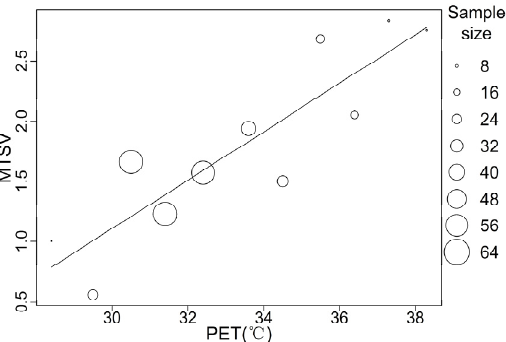
Figure 2. Percentage of TSV for the elderly in summer.